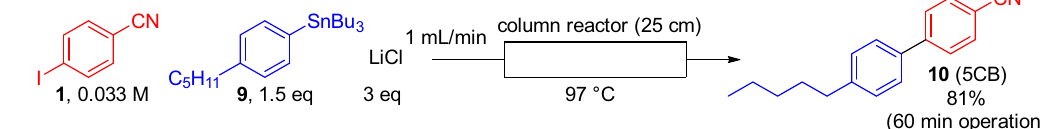
Scheme 1: Flow synthesis for liquid crystal